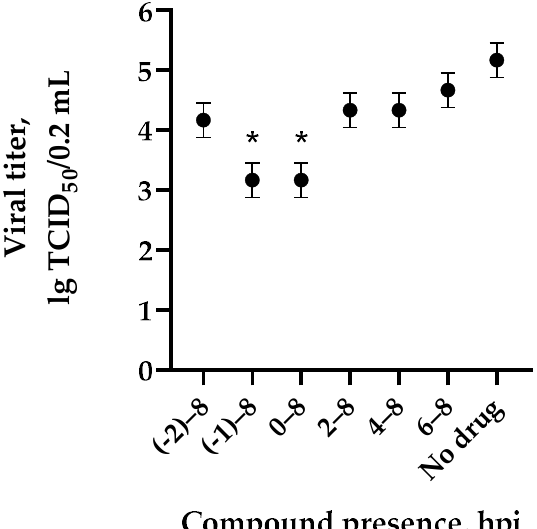
Figure 3. The effect of compound 1 on the values of infectious activity (Me [95% CI]) of the influenza A/Puerto Rico/8/34 (H1N1) virus depending on the time of addition to MDCK cell culture. The starting point of incubation was referred as 0. Cells were treated with fullerene derivatives for the time periods as following: (-2)–(-8) (before infection); (-1)–8 (simultaneously to absorption); 0–8; 2–8; 4–8; 6–8 and (-2)–8 hpi. Data are presented as mean ± SD of three independent experiments. *—differences are significant relative to “no drug” (Kruskal–Wallis test, p < 0.05).